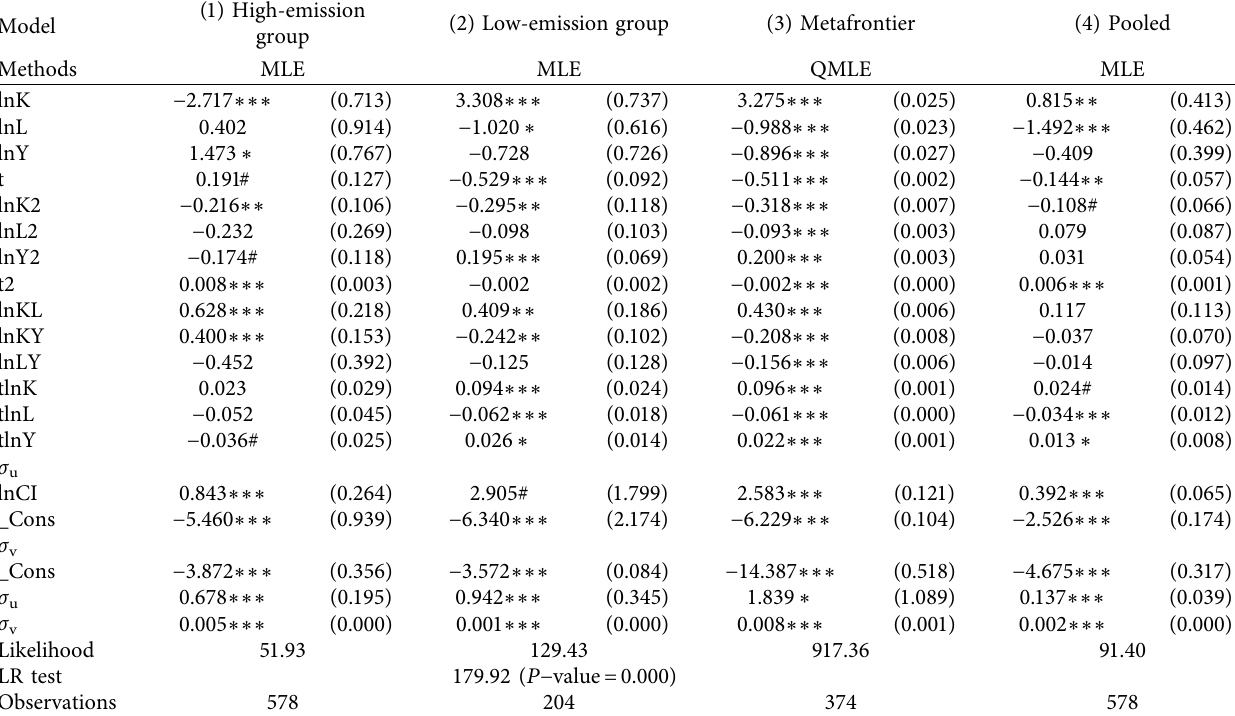
Table 3: Estimated results of different stochastic frontier